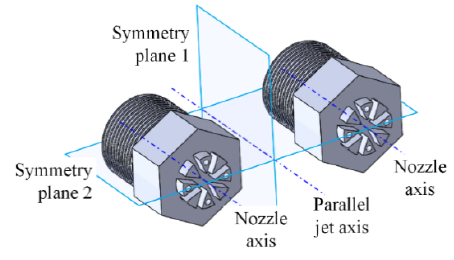
Figure 2. Space arrangement of the porous nozzle dual parallel jet.